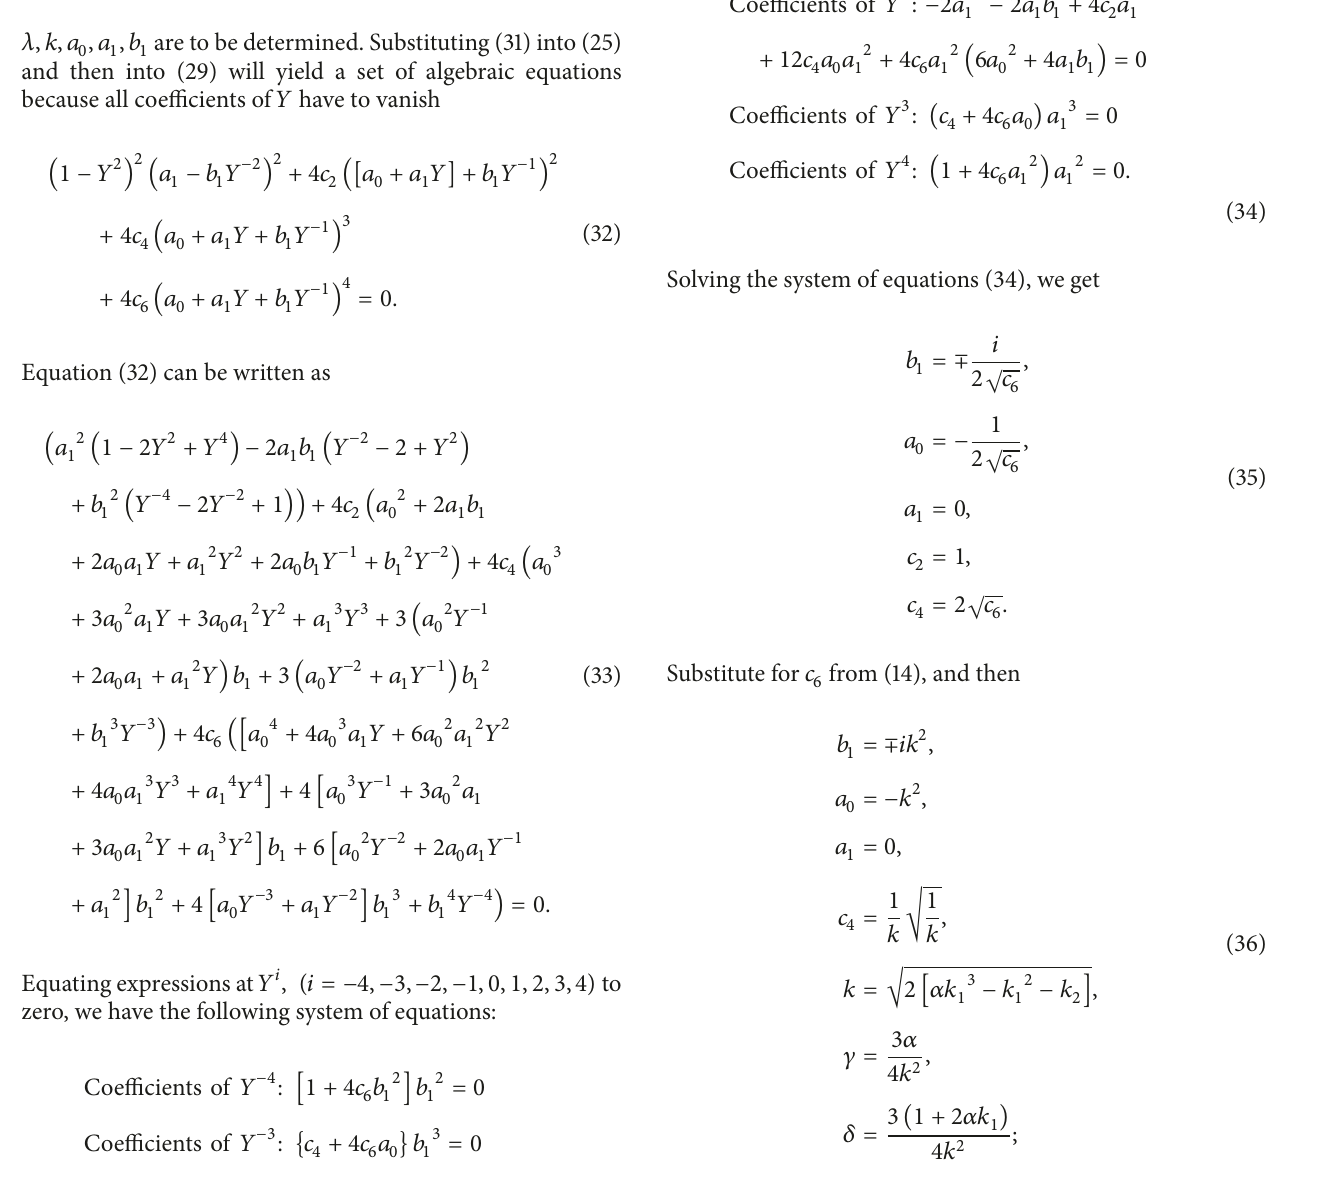
𝜆, 𝑘, 𝑎 , 𝑎 , 𝑏 0 1 1 are to be determined. Substituting (31) into